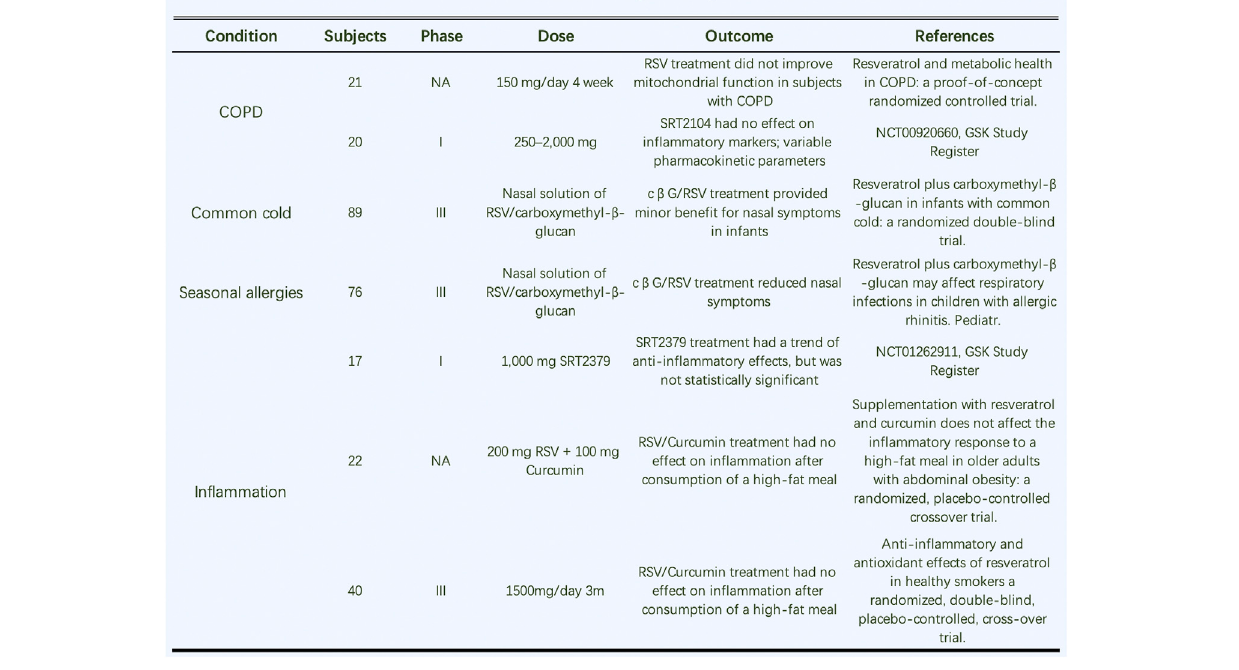
FIGURE 6 | Clinical trials of SIRT modulators for respiratory conditions or in fl